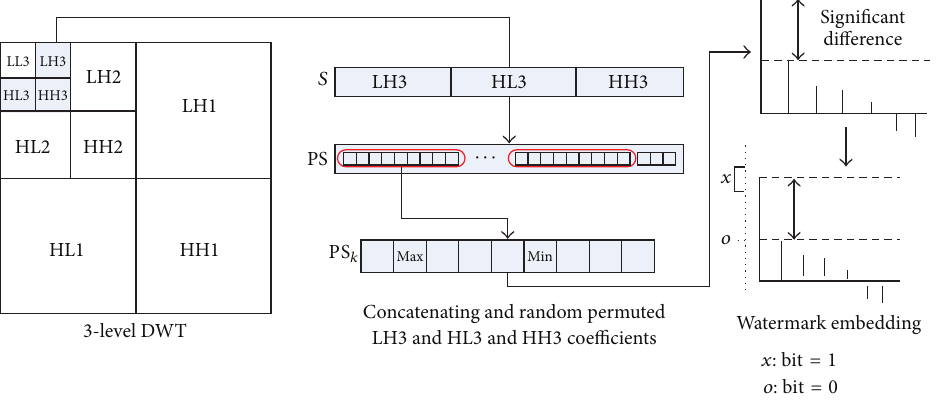
Figure 1: Watermark bits